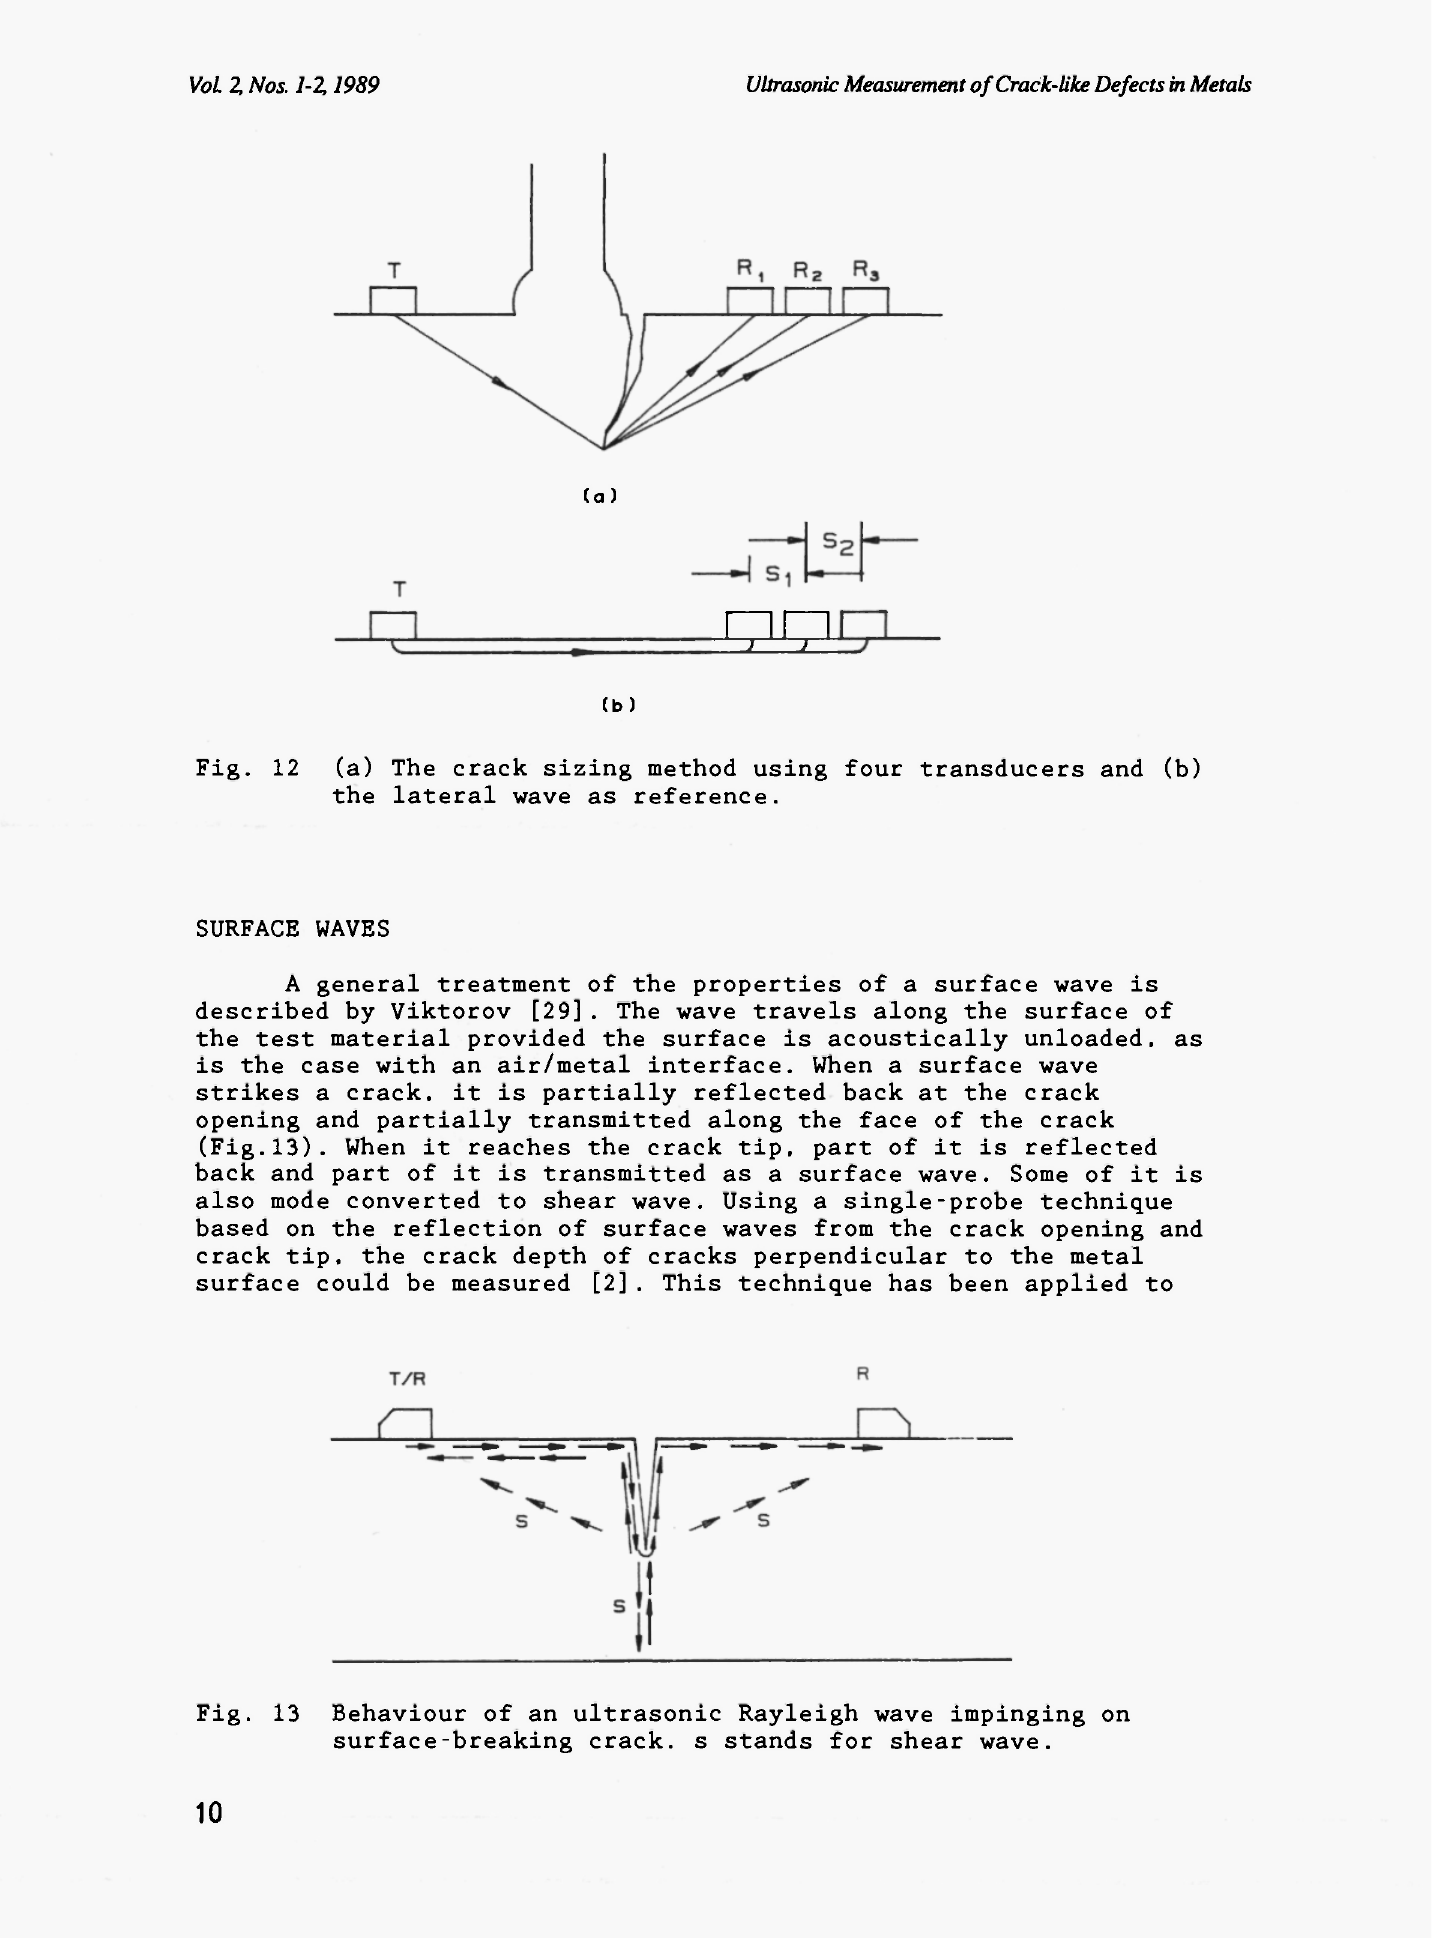
Fig. 13 Behaviour of an ultrasonic Rayleigh wave impinging on surface-breaking crack, s stands for shear